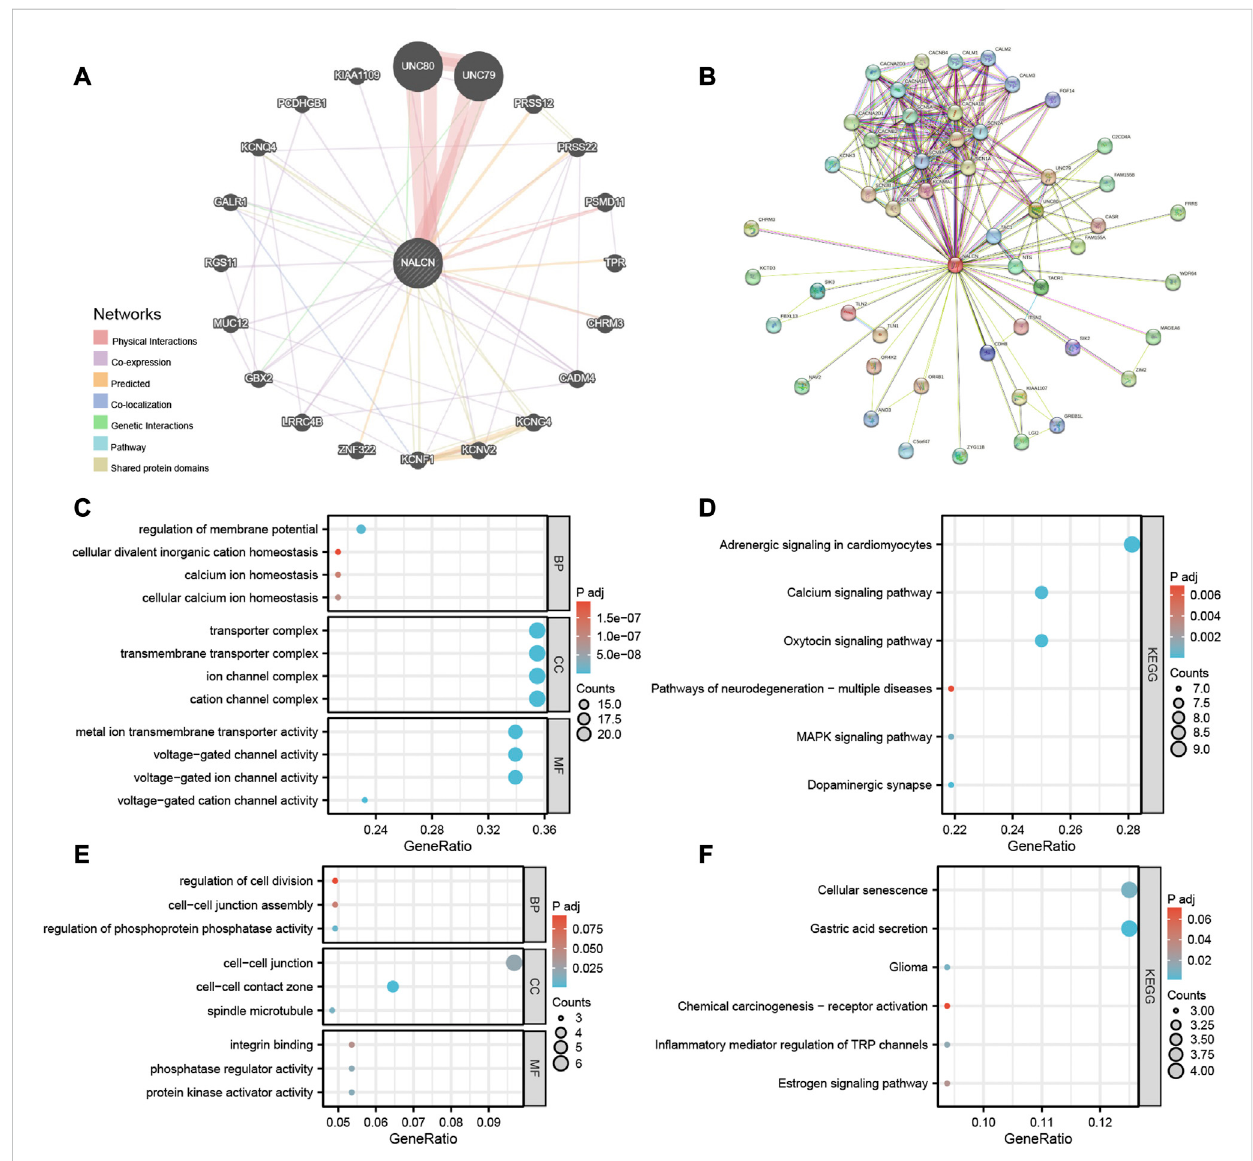
FIGURE 11 Gene-gene interaction network and enrichment analysis. (A) Gene-gene interaction network of NALCN from GeneMANIA. (B) Protein network of NALCN-binding proteins generated using STRING. (C) GO analysis, including the biological processes (BP), cellular components (CC), molecular functions (MF). (D) KEGG pathway analysis. (E) Representative GO analysis related to tumor. (F) Representative KEGG pathway analysis related to